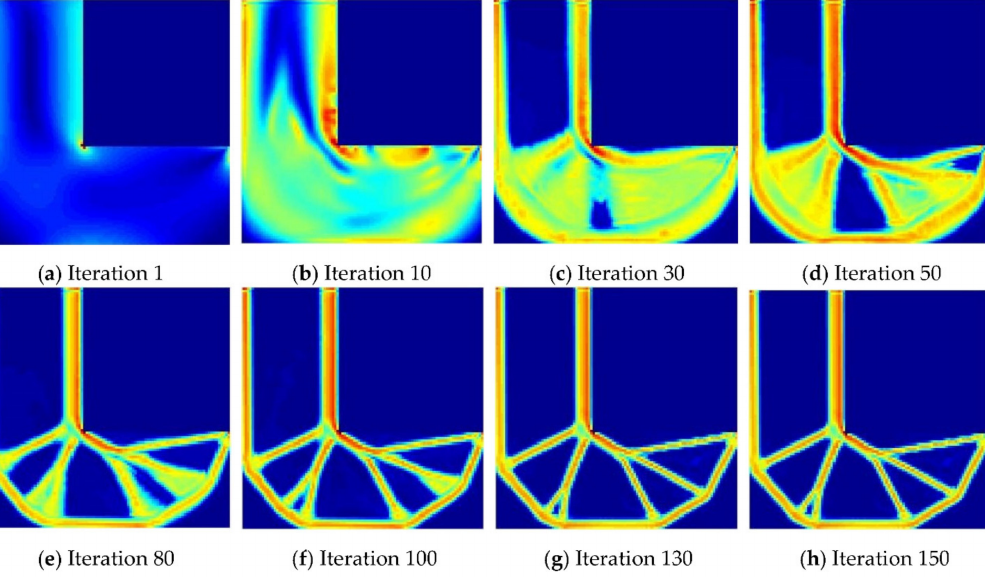
Figure 6. Structural evolution for reliability topology optimization with stress distribution ( a – h